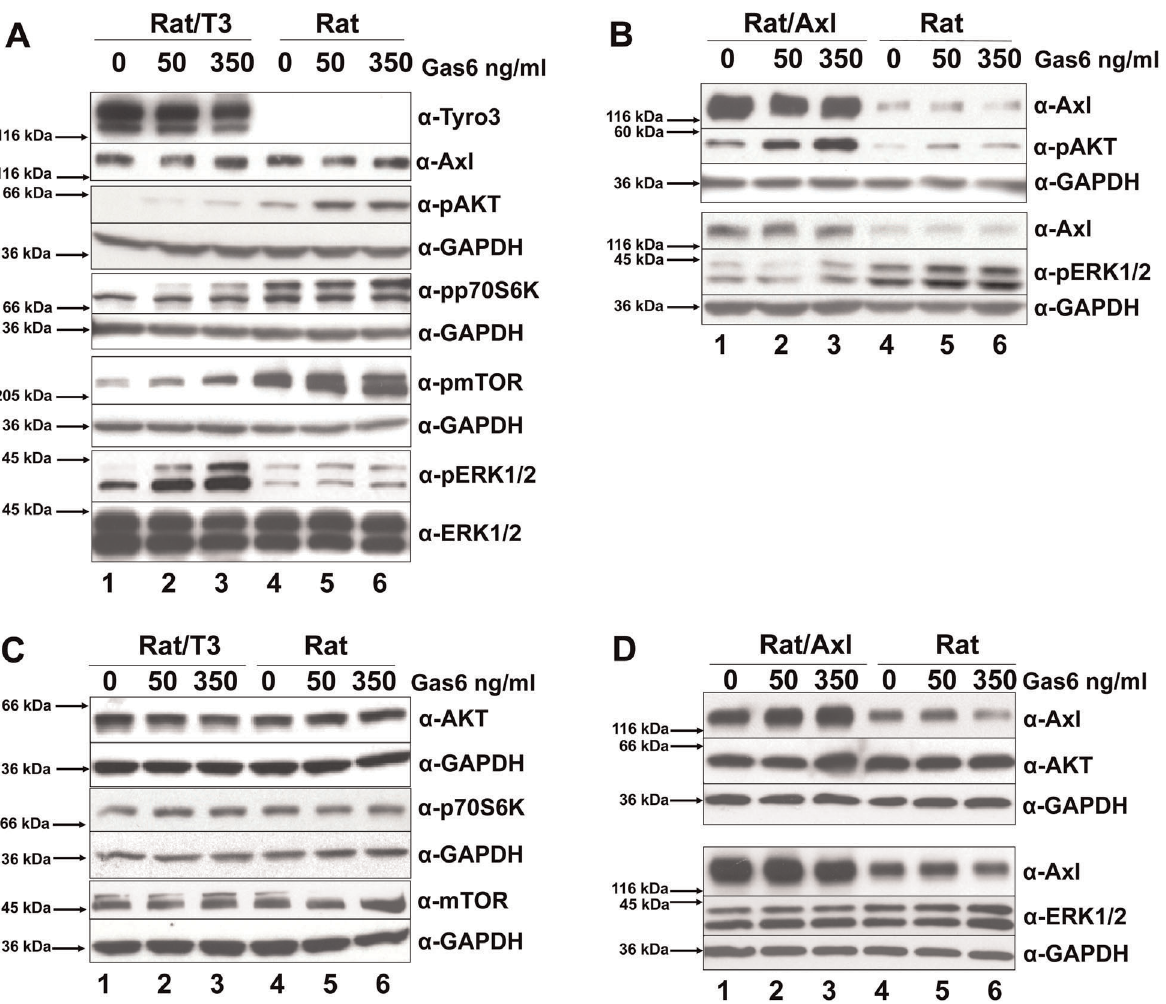
Figure 3. Tyro3 modulates MAPK and PI(3)K signaling pathways. As shown in panel A , Rat/T3V5 (Rat/T3, lanes 1–3) and Rat2 cells (Rat, lanes 4–6) were treated with 0, 50, and 350 ng/ml of Gas6 for 20 min. Detergent cell extracts normalized for protein concentration were separated by SDS-PAGE using 4–20% gels. Western blotting was performed with antibodies directed against a -Tyro3, a -Axl, a -pAKT, a pp70S6K, a -pmTOR, and a -pERK1/2. The membranes were stripped or cut and reprobed with a -ERK1/2 or a -GAPDH and shown beneath each panel as protein loading control. These blots are representative of 5 experiments. As shown in panel B , transiently transfected Rat2/Axl cells (Rat/Axl, lanes 1–3) and Rat2 cells (Rat, lanes 4–6) were treated and processed as above. Western blotting was performed with a -Axl, a -pAKT, and a -pERK1/2. The membranes were cut and reprobed with a -GAPDH shown beneath each panel as protein loading control. These blots are representative of 4 experiments. The total levels of MAPK and PI(3)K signaling pathway molecules was compared in Rat2 cells overexpressing Tyro3 (panel C) and Axl (panel D). For Tyro3 overexpressing cells (panel C), Rat/T3V5 cells (Rat/T3, lanes 1–3), and Rat2 untransfected cells (Rat, lanes 4–6), were treated with 0, 50 and 350 ng/ml of Gas6 for 20 min. Detergent cell extracts normalized for protein concentration were separated by SDS-PAGE using 4–20% gels. Western blotting was performed with antibodies directed against a -AKT, a p70S6K, a -mTOR. The membranes were cut and reprobed with a -GAPDH shown beneath each panel as protein loading control. For total levels of Tyro3, Axl, and ERK1/2 in Rat2 and Rat2/T3V5 cells, see Fig. 3 A and B . These blots are representative of 4 experiments. For Axl overexpressing cells (panel D), t ransiently transfected Rat2/Axl cells (Rat/Axl, lanes 1–3) and Rat2 untransfected cells (Rat, lanes 4–6) were treated and processed as above. Western blotting was performed with a -Axl, a -AKT, and a -ERK1/2. The membranes were cut and reprobed with a -GAPDH shown beneath each panel as protein loading control. These blots are representative of 4